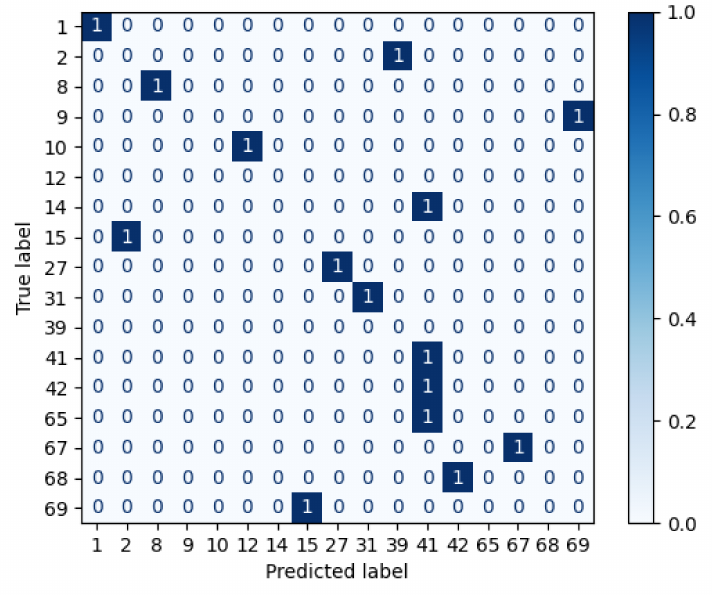
Figure 13. Confusion matrix with 25% visible facial